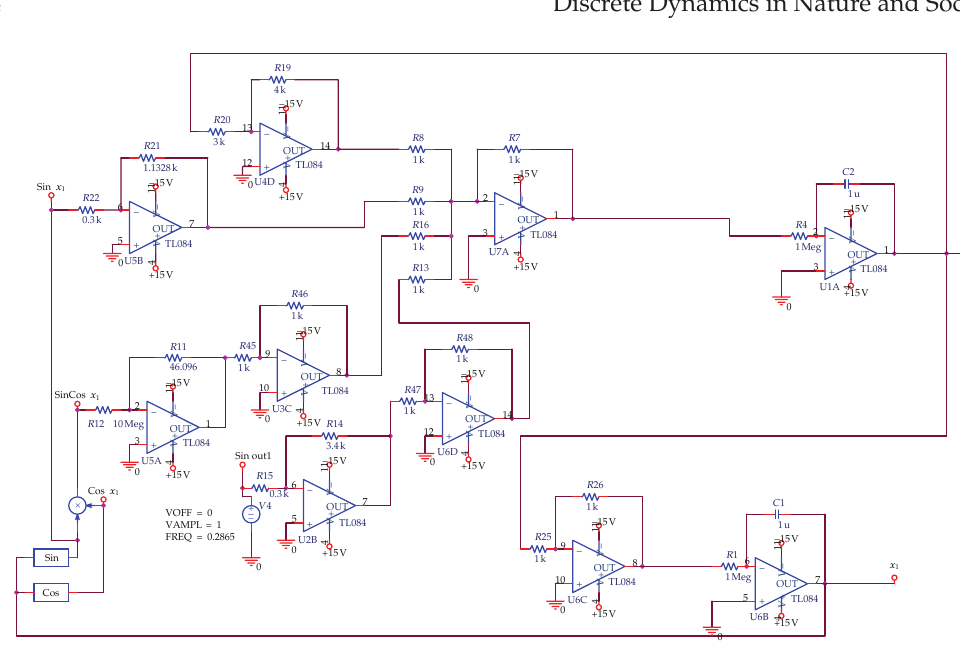
Figure 2: The electronic HPS circuit.